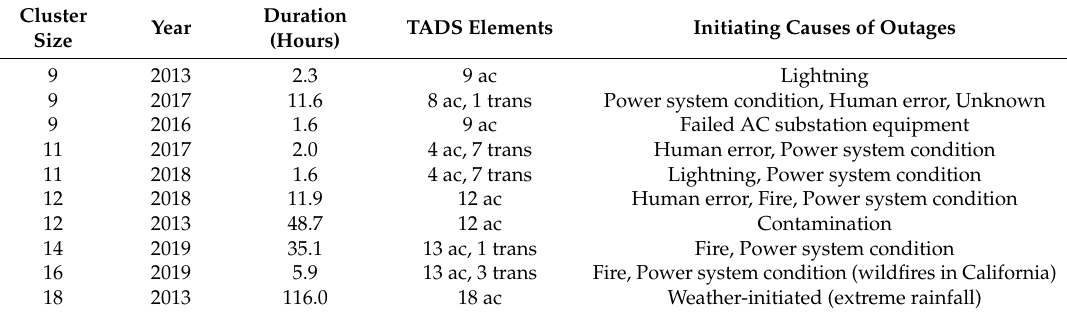
Table 3. Ten largest clusters